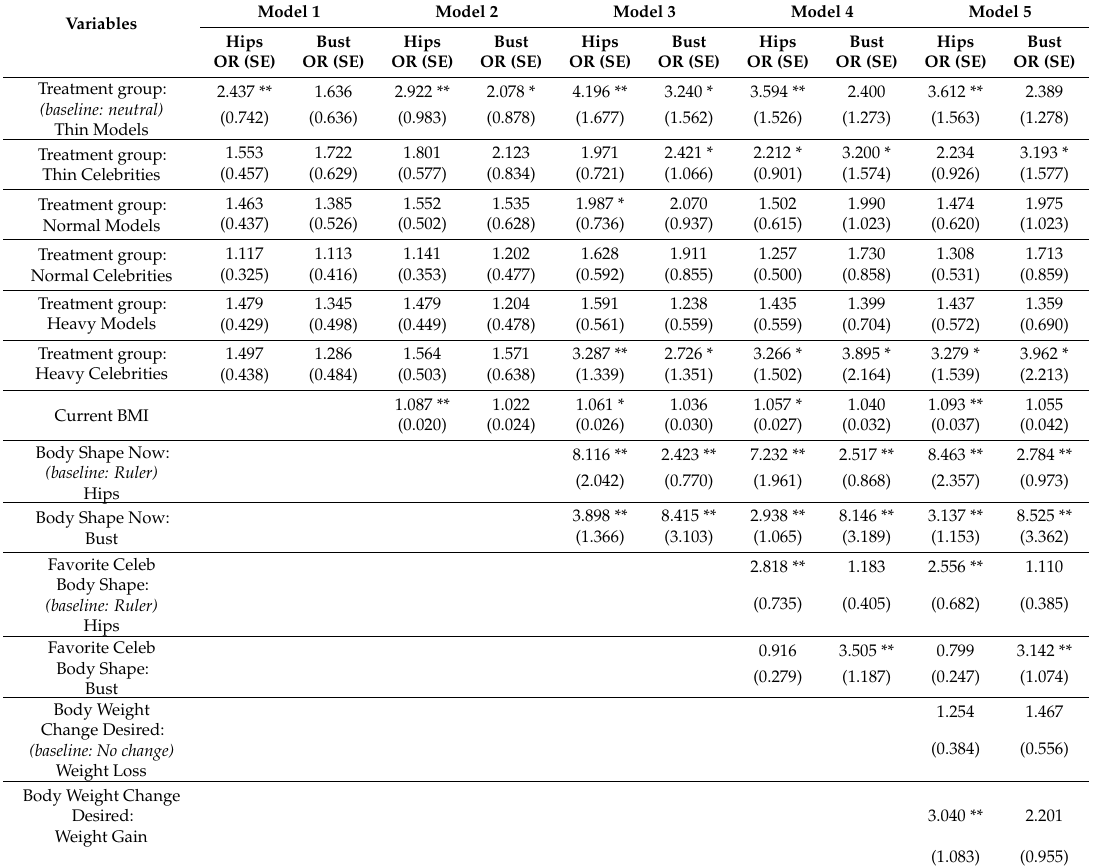
Figure 2. Predictive Margins for Average-sized celebrities Treatment and Favorite Celebrity Body Size (Thin versus Heavy). Table 4. Multinomial Logistic Models for Ideal (Desired) Body